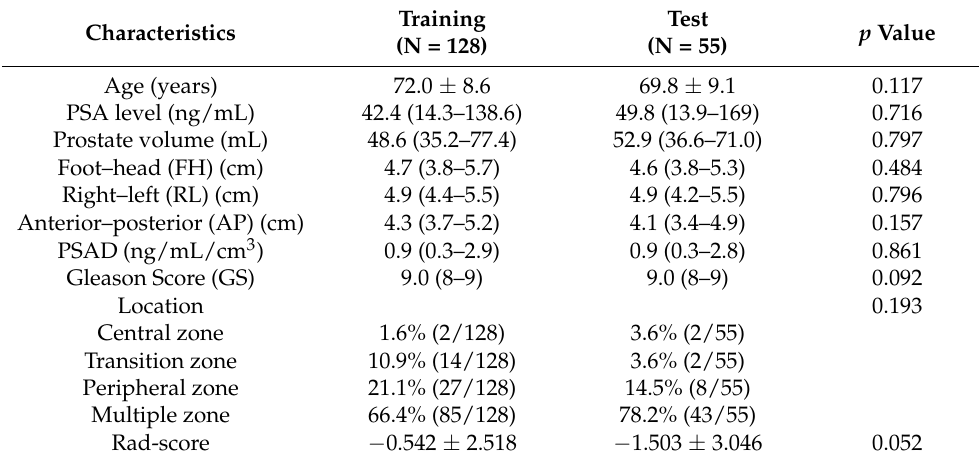
Table 2. Patient clinic radiological characteristics between training and test